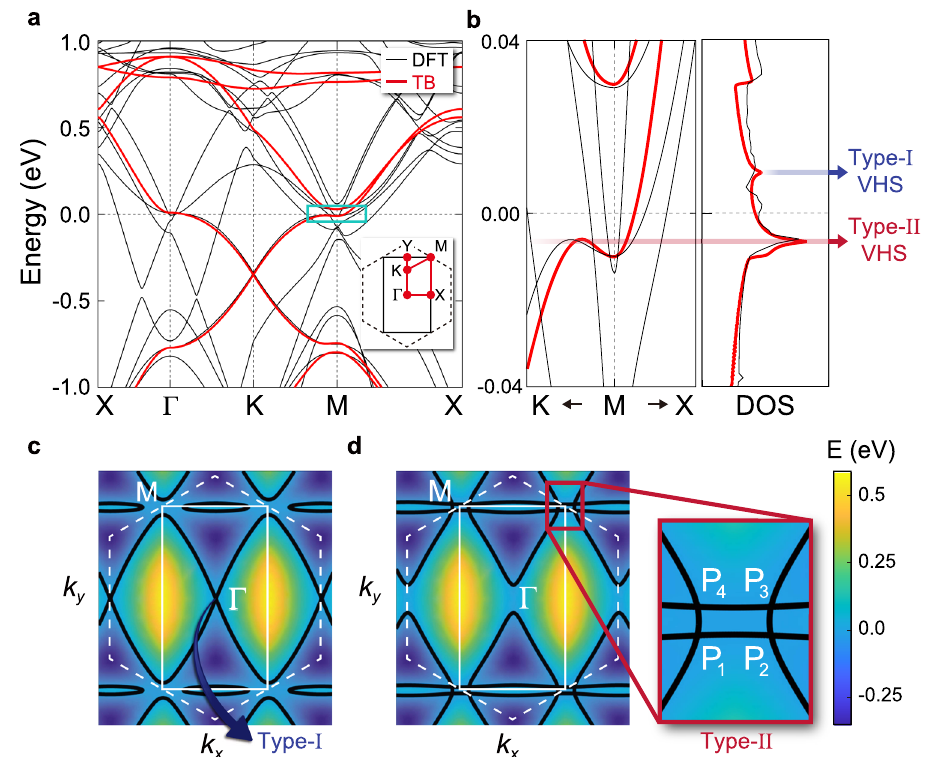
Fig.2|VHSsinthemonolayer A V 3 Sb 5 .a DFTandTBbandstructuresoftheKV 3 Sb 5 monolayer. The DFT (TB) bands are colored by black (red). The kagome bands are reproducedbyusingourTBmodel(seeMethodsforthedetailsoftheTBmodel).A solid rectangle (dashed hexagon) in the inset depicts the reduced (pristine) BZ of ffiffiffi p the 3 ×1 (1×1) unit cell. b (Left panel) Magni fi ed view of the blue box in a . (Right panel) Density of states (DOS) of KV 3 Sb 5 . The type-I and type-II VHSs are indicated